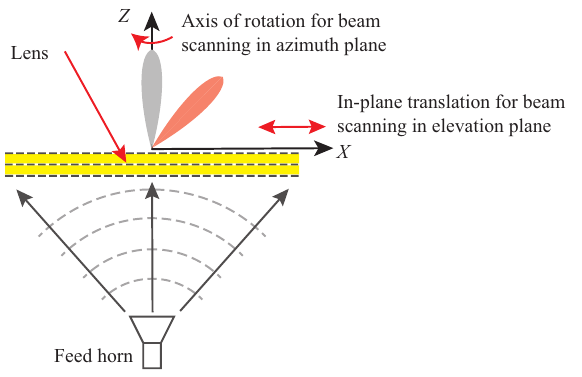
Figure 6. Schematic view of the lens mounting